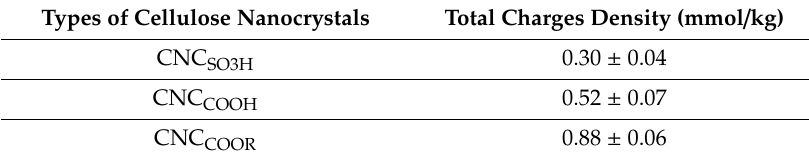
Table 2. Total charges density of the three types of cellulose nanocrystals, mean ± standard deviation ( n = 3).